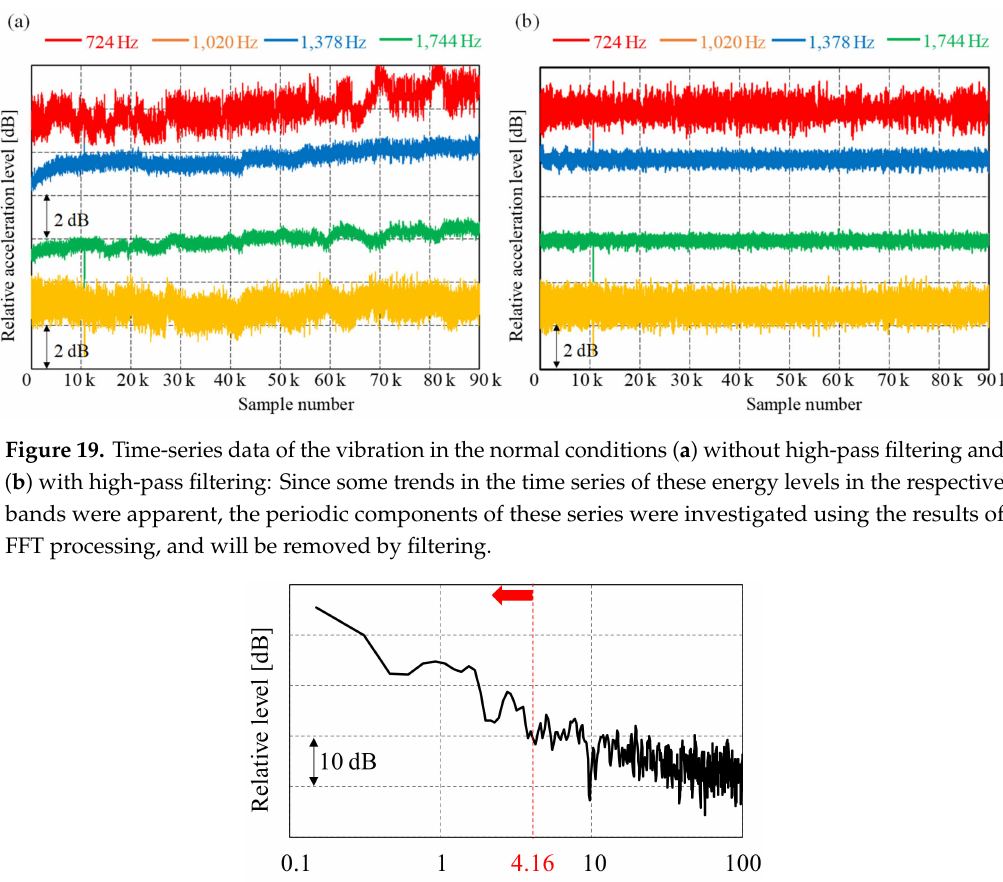
Figure 18. Selection method using frequency bands to calculate the MD 2 of the lifter: From these frequency characteristics of the vibration data obtained from R1 during normal operation, the energy levels in the 1 / 12 octave band around the four prominent peak frequencies at 724 Hz, 1020 Hz, 1378 Hz, and 1744 Hz were obtained and used for the calculation of MD 2 .